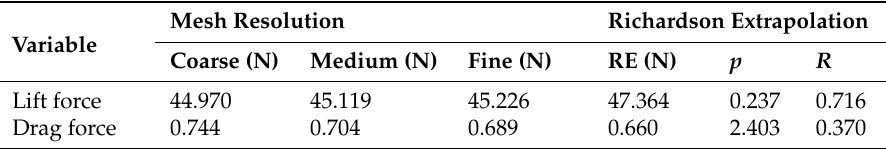
Table 2. Results of the mesh dependency study with VGs at α = 11 ◦ .